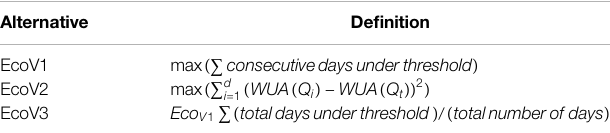
TABLE3| De fi nitionofthethreealternativescomparedinthesensitivityanalysisto evaluate the fi sh habitat suitability indicator (d corresponds to the number of consecutive days under the